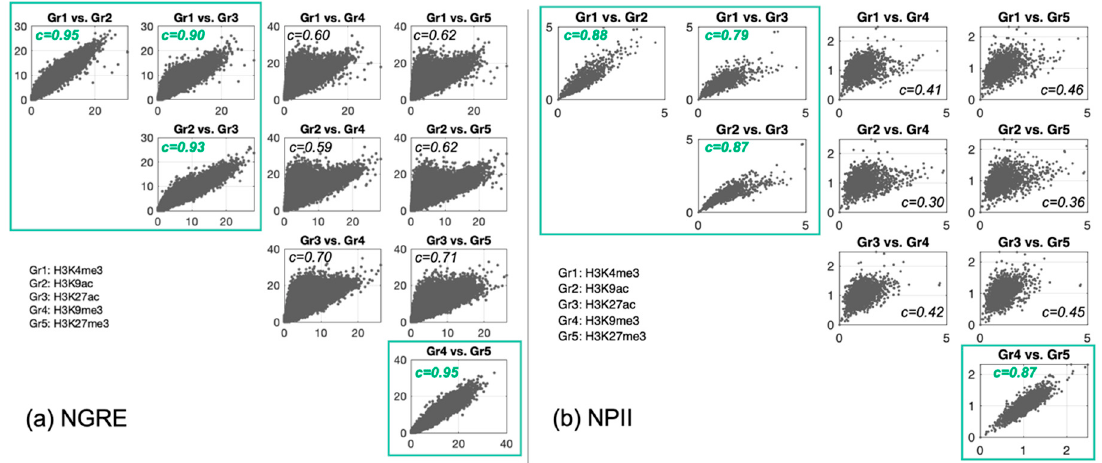
Figure 3. Scatterplots of ( a ) (normalized gene RE-linked enrichment score (NGRE) against NGRE) and ( b ) (normalized pathway involvement index (NPII) against NPII) for five histone tags in Homo sapiens . Each dot represents a single gene. Correlation values are denoted with c and showed within each subplot; all values were statistically significant ( p -value < 0.001). Green squares highlight highly correlated histone tags ( c > 0.75).